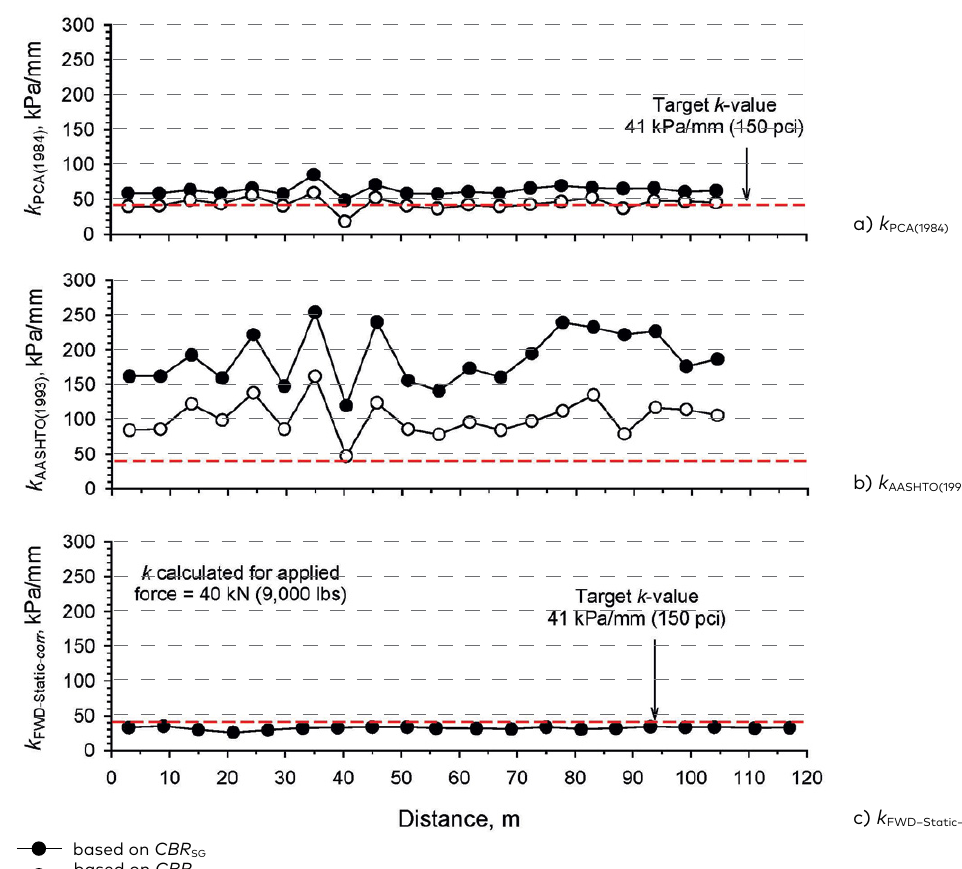
Figure 6. Estimated k values based on different